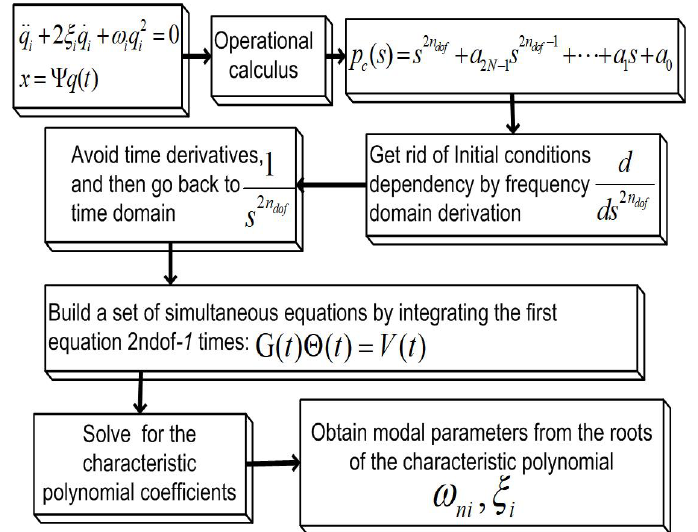
Figure 2. Algebraic identification